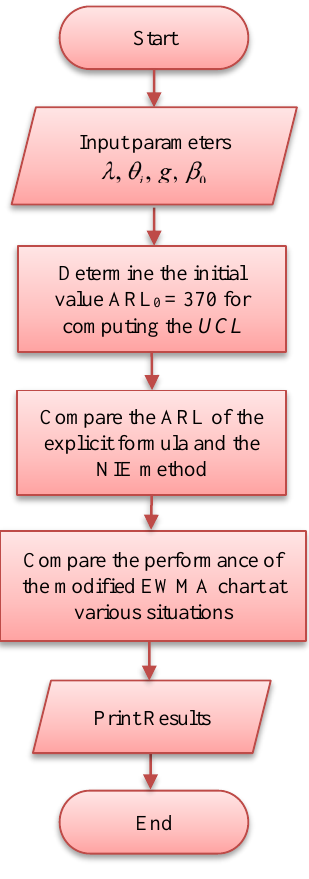
Figure 1. The diagram of the research